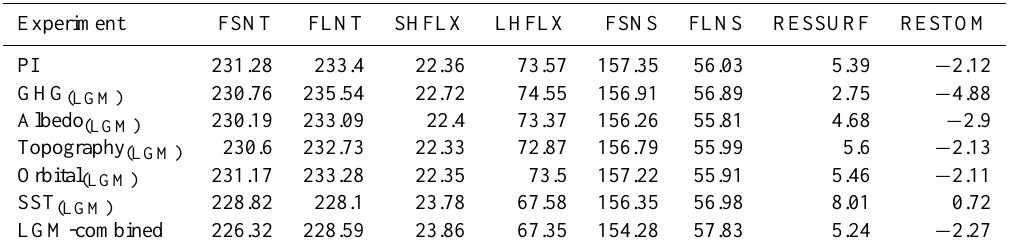
Table 5. Global annual mean of energy terms in the model for the different